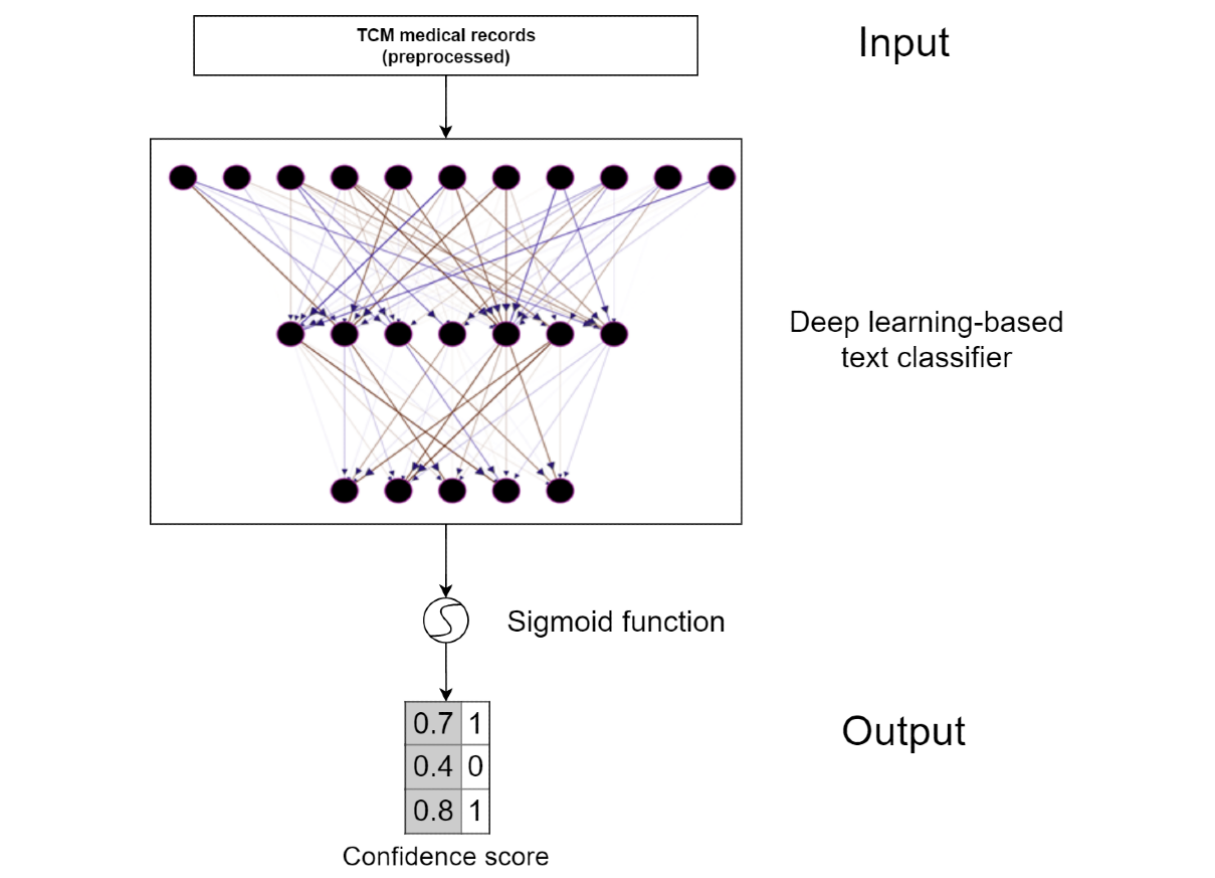
Figure 2. Schematic of the deep learning–based multilabel